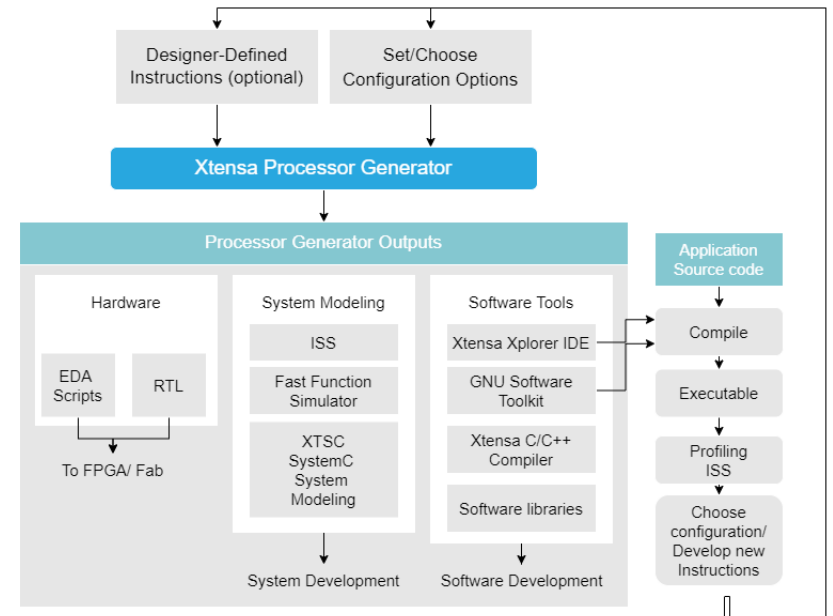
Figure 2. Tensilica design schema